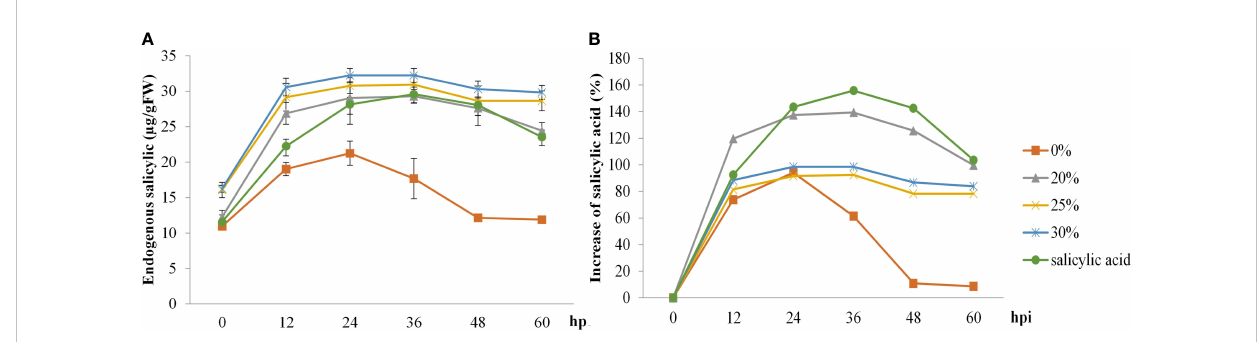
FIGURE 5 Endogenous salicylic acid (SA) activity in ‘ KDML 105 ’ treated with biosurfactant following Magnaporthe oryzae infection. (A) Endogenous SA content and (B) relative increase in endogenous SA content.